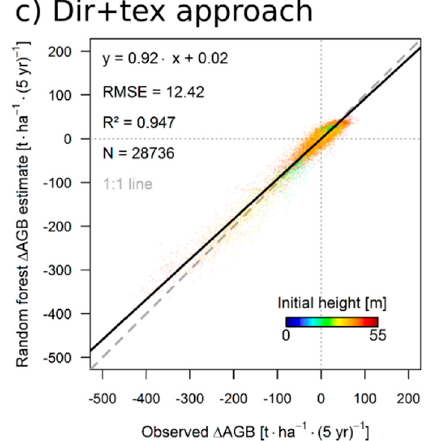
Figure 4. The 1:1-plots of estimated Δ AGB versus observed Δ AGB following ( a ) the direct; ( b ) the indirect and ( c ) the dir+tex approach. Each point represents a 1 ha forest-stand. Colors indicate initial height (TCH10) of each stand. Black lines represent linear regression models.